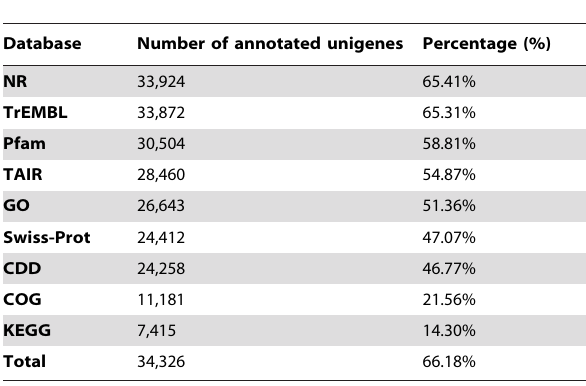
Table 2. Functional annotation of yellow horn unigenes in public protein